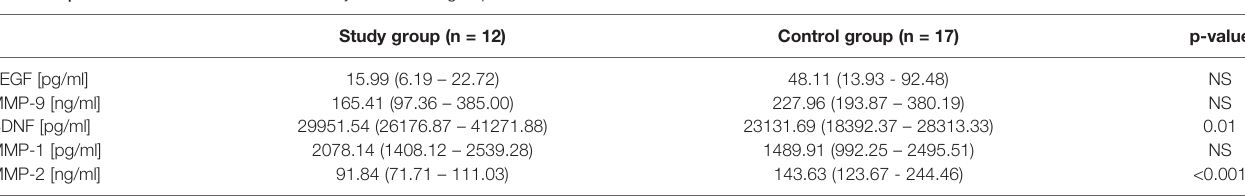
TABLE 3 | Markers ’ concentrations in the study and control